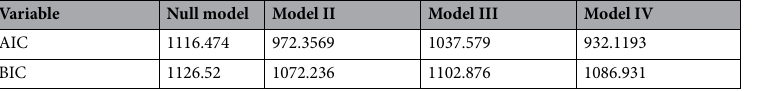
Table 3. Factors associated with unintended pregnancy were identified through multilevel logistic regression. Signif. codes: ‘***’ < 0.001 ‘**’ < 0.01 ‘*’ <